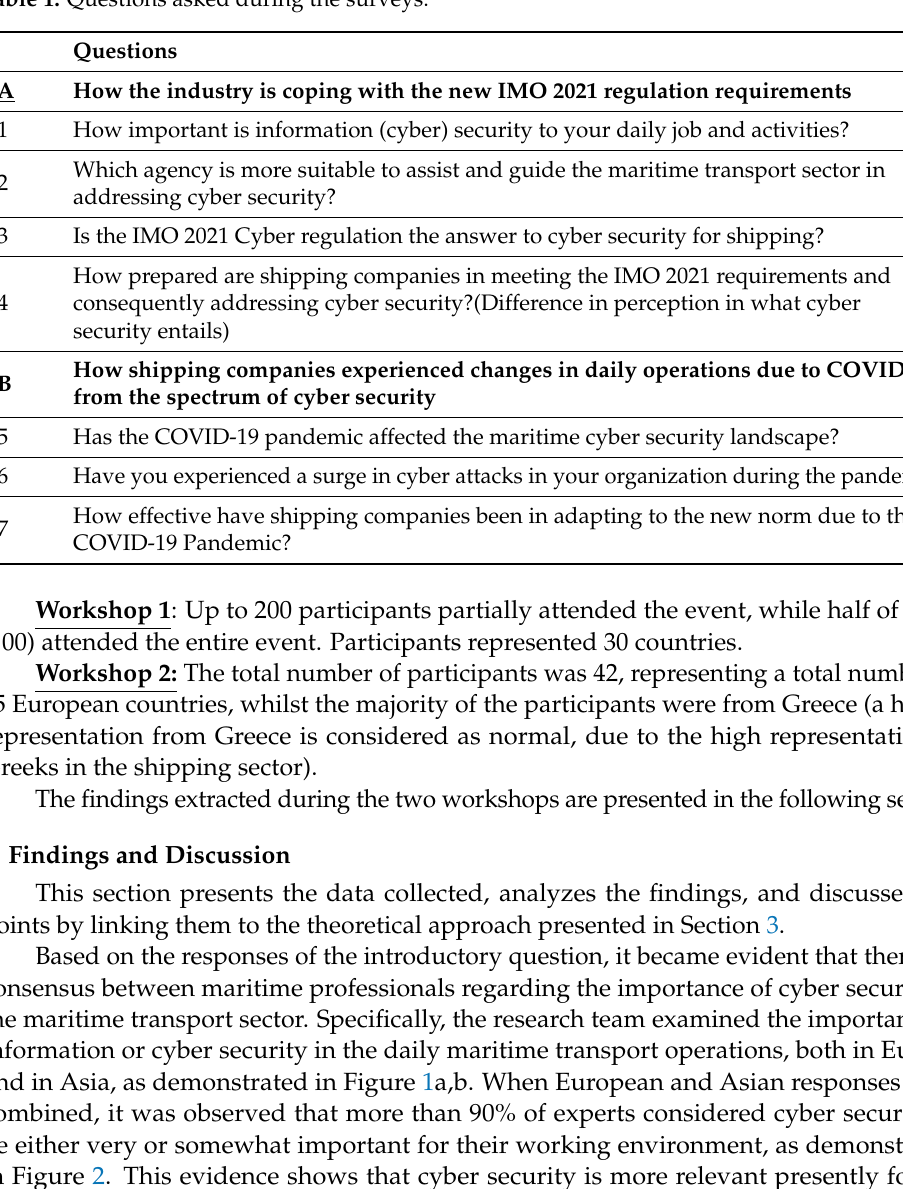
Table 1. Questions asked during the